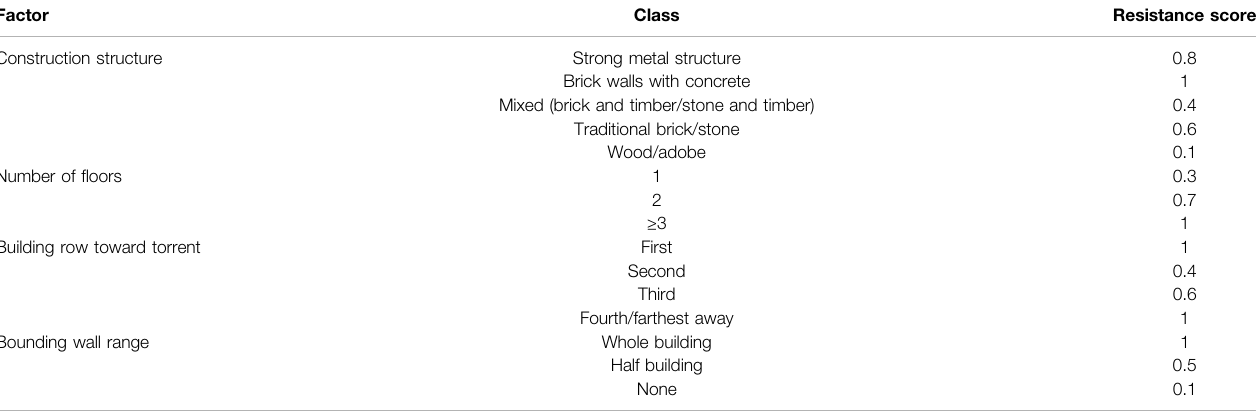
TABLE 2 | Proposed values of the resistance scores of buildings. Factor Class Resistance score